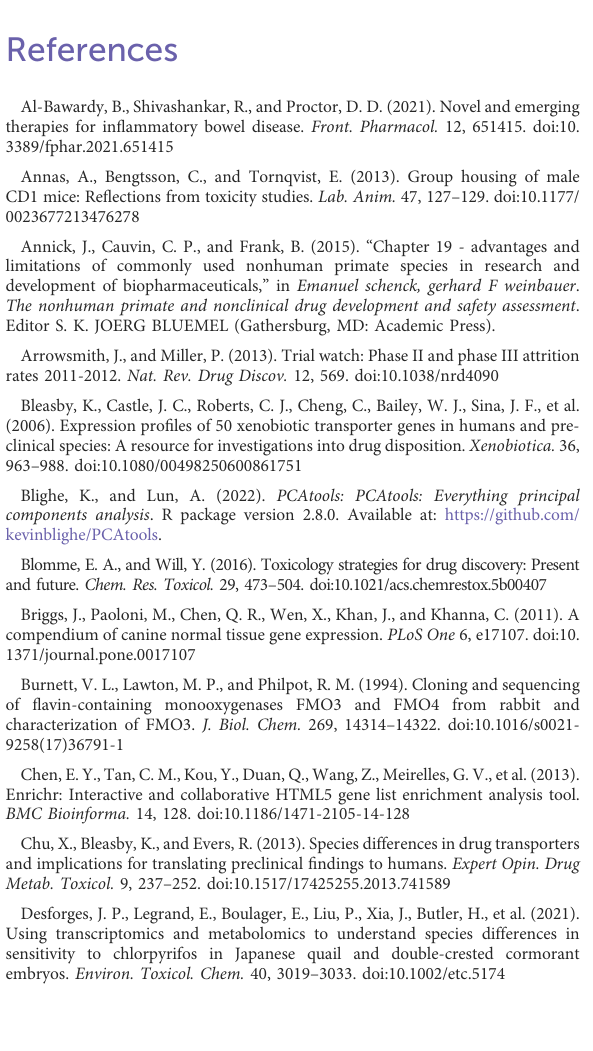
expressed transcripts in each tissue was calculated across dog (A) and monkey (B) .